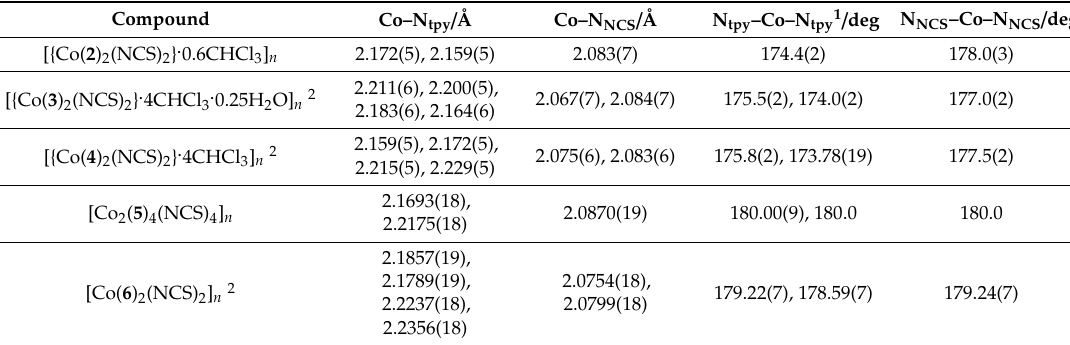
Table 1. Bond lengths and angles in the cobalt(II) coordination